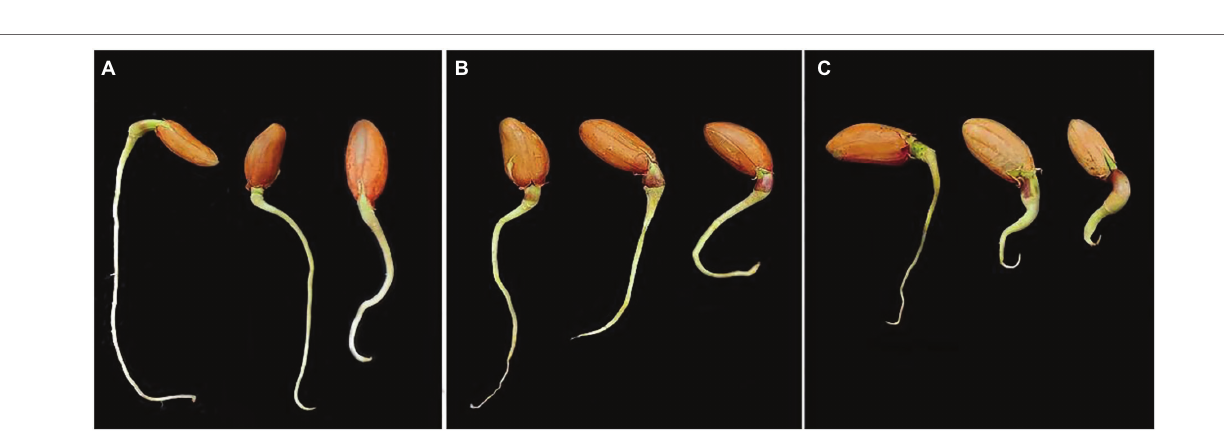
FIGURE 6 | Response of the germinated peanut seeds to various treatments after 14 days. Where, CA treatment (A) , fungicide treatment (B) , and controls (C) , showing the various promoting